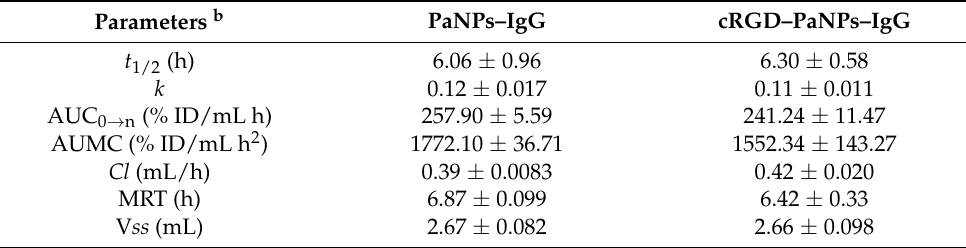
Table 1. Pharmacokinetic parameters of Pa after i.v. injection cRGD–PaNPs–IgG or PaNPs–IgG (5 mg/kg of Pa, 5 mg/kg of IgG) into female BALB/c mice a